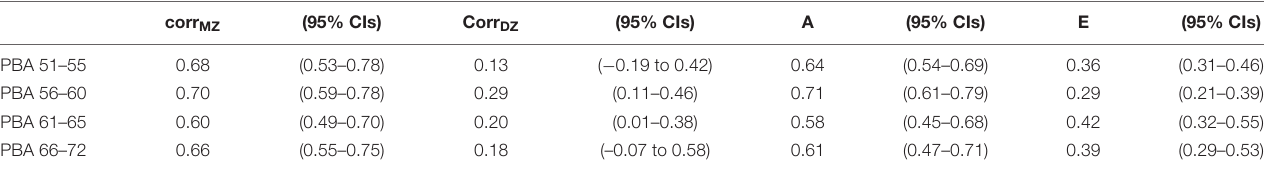
TABLE 2 | Predicted brain age monozygotic and dizygotic twin pair polyserial correlations (corrMZ and CorrDZ) along with standardized variance components and 95% confidence intervals components for the best-fitting additive genetic (A) and non-shared environment (E) univariate models. corr